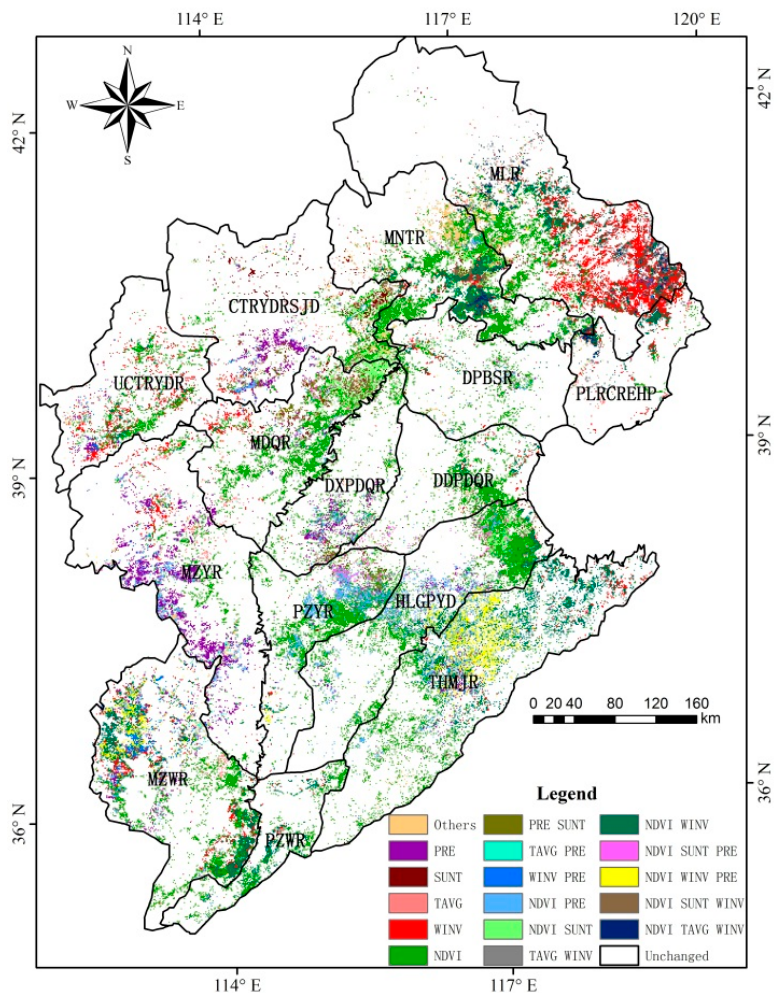
Figure 7. Factors (NDVI, air pressure, sunshine time, wind speed, relative humidity and average air temperature) that are significantly correlated (Pearson relationship coefficient of R > 0.51) with ET in areas of significant or marginally significant changes in ET from 2000 to 2014. Assuming that ET and all factors have bivariate normal distributions, the variable t = r(cid:3495) (cid:2924)(cid:2879)(cid:2870) Factors are significantly correlated with ET when R > 0.51 (T > T α [61].